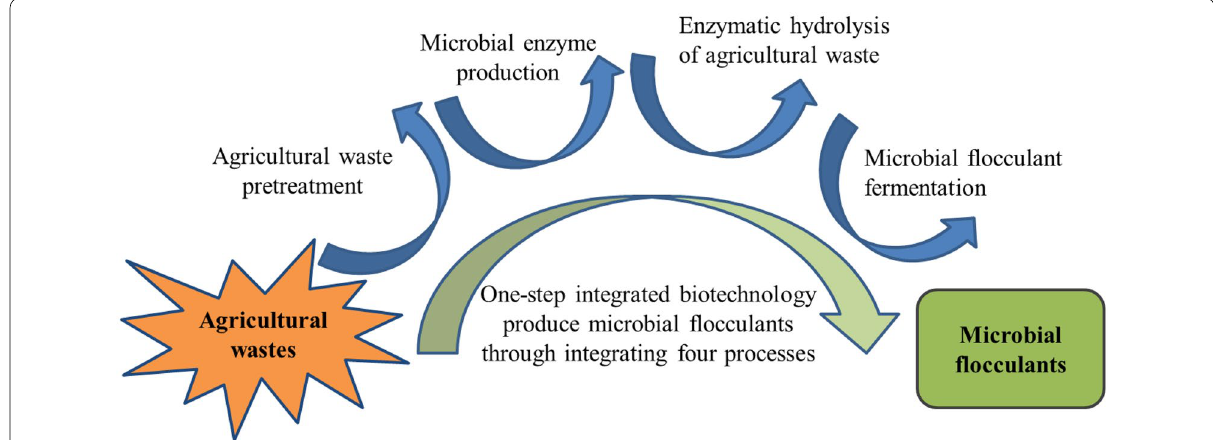
Fig. 1 Microbial flocculant produced by one-step integrated